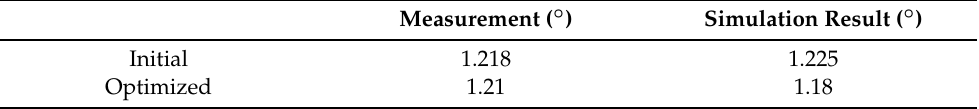
Table 7. Comparisons of measurement and simulation results of the spring-back